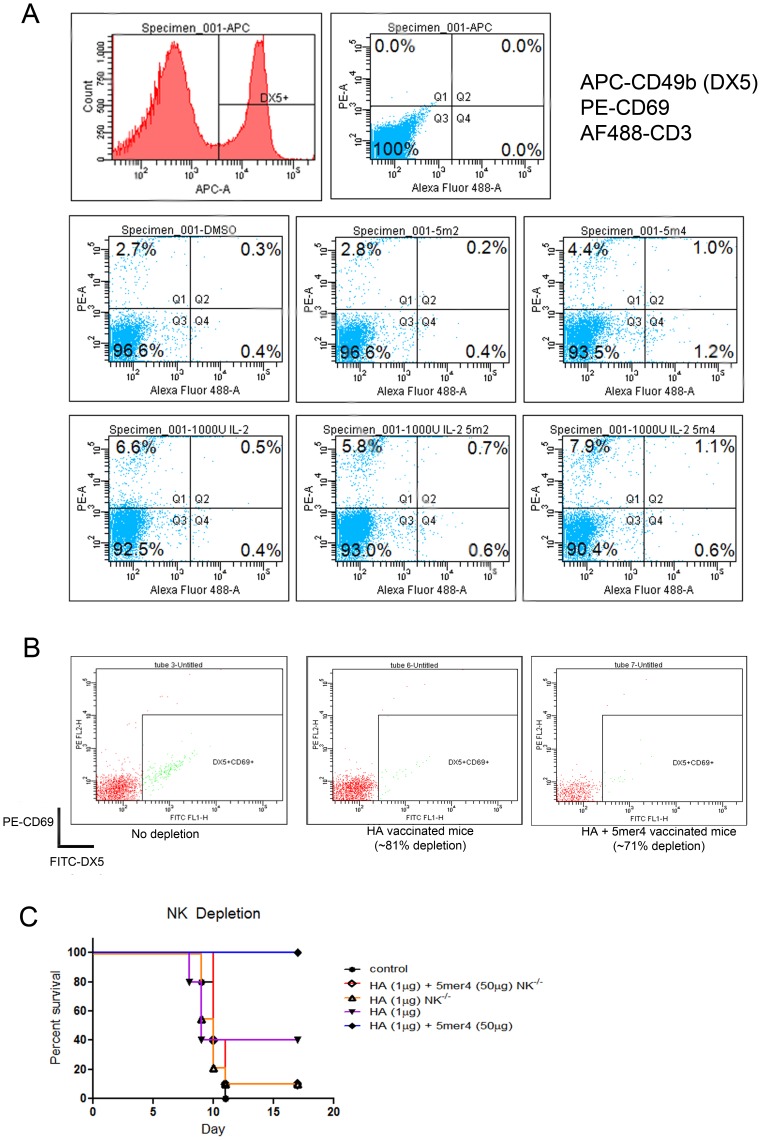
Evaluation of NK cell responses in response to 5mer4.(a) NK cells were isolated from the spleen of BALB/c mice using negative selection. Cells were incubated overnight in the presence of 100 U/ml recombinant IL-2, with 2.5 µg/ml of 5mer4, 5mer2 control, DMSO control. Additional groups of cells were incubated with 1000 U/ml IL2 and 1000 U/ml IL2 combined with 5mer4 (2.5 µg/ml). NK cell activation was monitored for PE-CD69 upregulation on APC-DX5+ cells by flow cytometry. All cells were CD3−. The data is representative of three independent experiments performed on different days. (b) NK depletion in BALB/c mice. Mouse NK cells were depleted by administration of anti-asialo antibody at day -2 and day -1 before vaccination. Whole blood samples were collected from the saphenous vein (50 µl) from NK-depleted and undepleted control animals. All samples were first treated with ACK lysis buffer to remove red blood cells and then stained with PE-CD69 and FITC-DX5 to detect the percentage of NK cells remaining following depletion. (c) Survival of vaccine groups following NK cell depletion. At day 0, NK-depleted BALB/c mice were immunized with H5N1-HA (1 µg) or H5N1-HA (1 µg) + 5mer4 (50 µg), or PBS control. Three groups of mice that were not depleted were immunized with H5N1-HA (1 µg), H5N1-HA (50 ug) or H5N1-HA + 5mer4 (50 µg) as controls. Animals were challenged with 100LD50 of homologous H5N1-H05 virus and survival was monitored over 17 days. Groups of 8–10 BALB/c mice were evaluated.